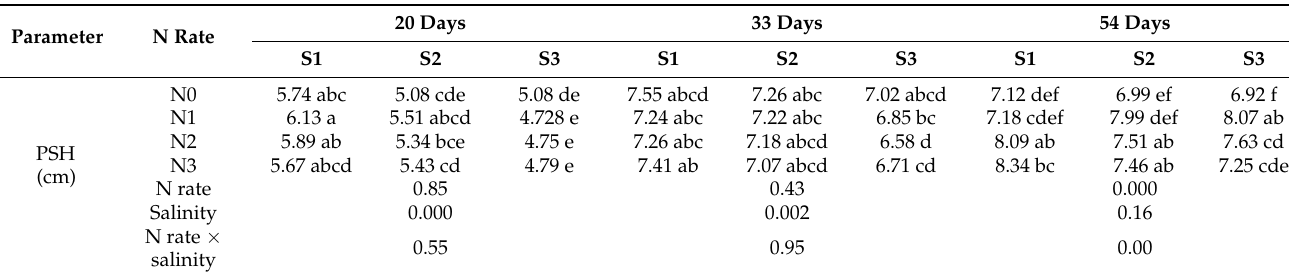
Table 7. Effects of nitrogen application rates with different soil salinity levels on Pseudo stem height (PSH) in different growth stages of winter